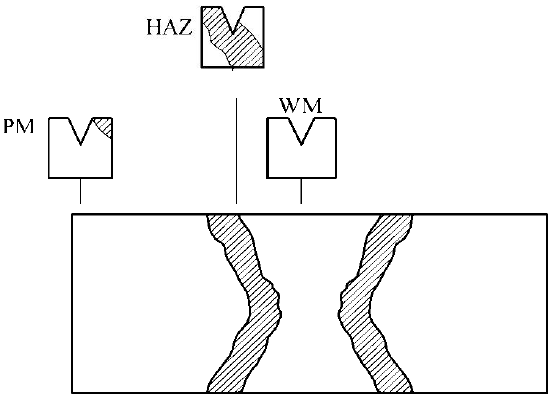
Figure 2. Welded joint Charpy specimen cutting scheme.